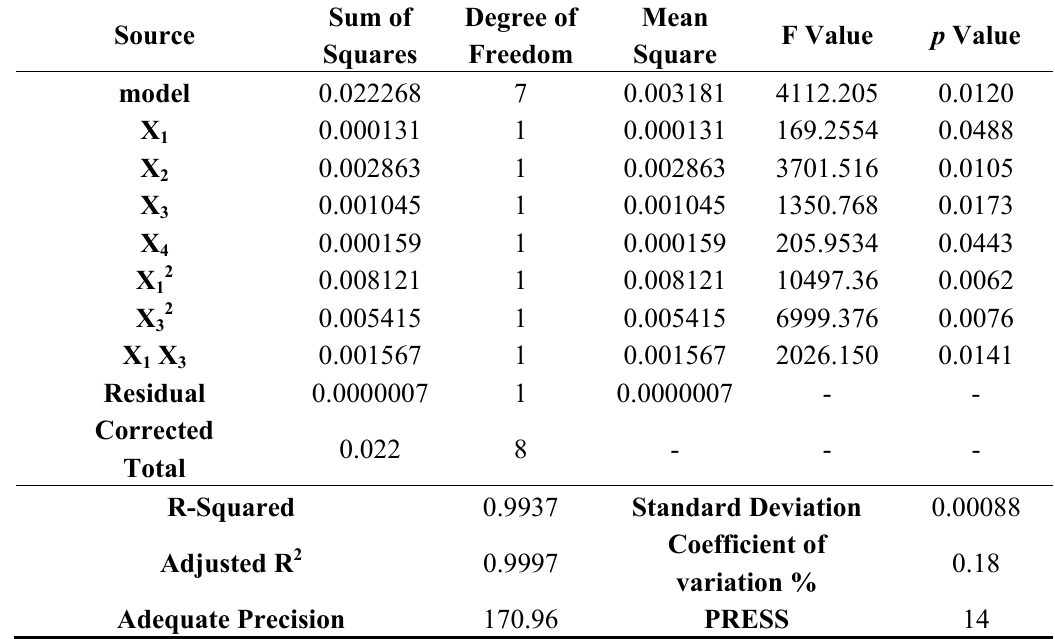
Table 3. Analysis of variance for energy band gap of SnO